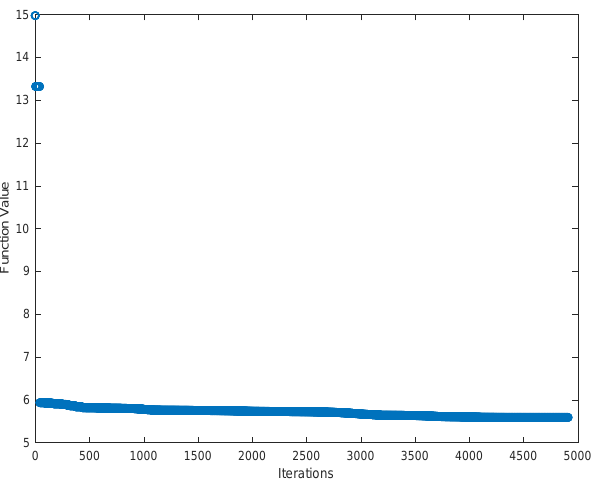
Figure 3. (Left) The Laguerre Voronoi diagram of the generator set generated from the graph drawing-based point placement; (Right) The resulting Laguerre Voronoi diagram after employing the optimization with parameter ω = 7 / 8